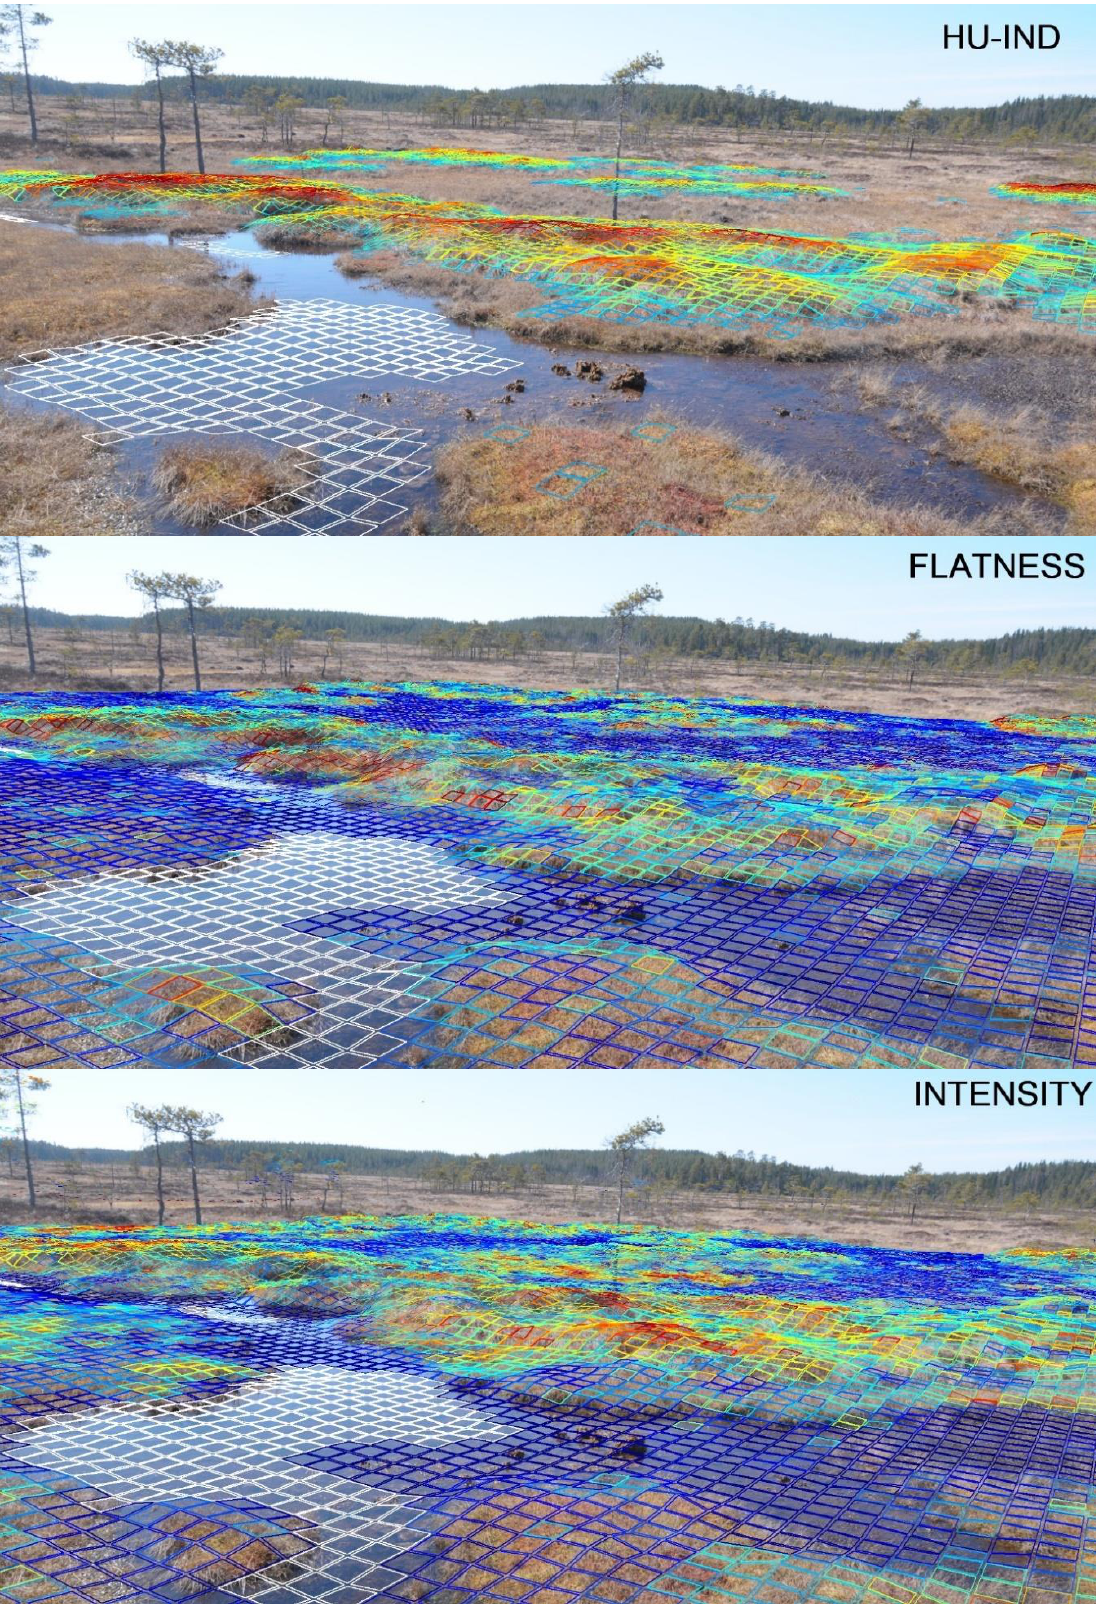
Figure 7. Illustration of the HU-IND (large values only), FLATNESS and INTENSITY feature maps. The white cells are WATER. FLATNESS peaks in slopes. INTENSITY is high in hummocks and low in water, hollows and mud-bottoms. The raster cells are 20 × 20